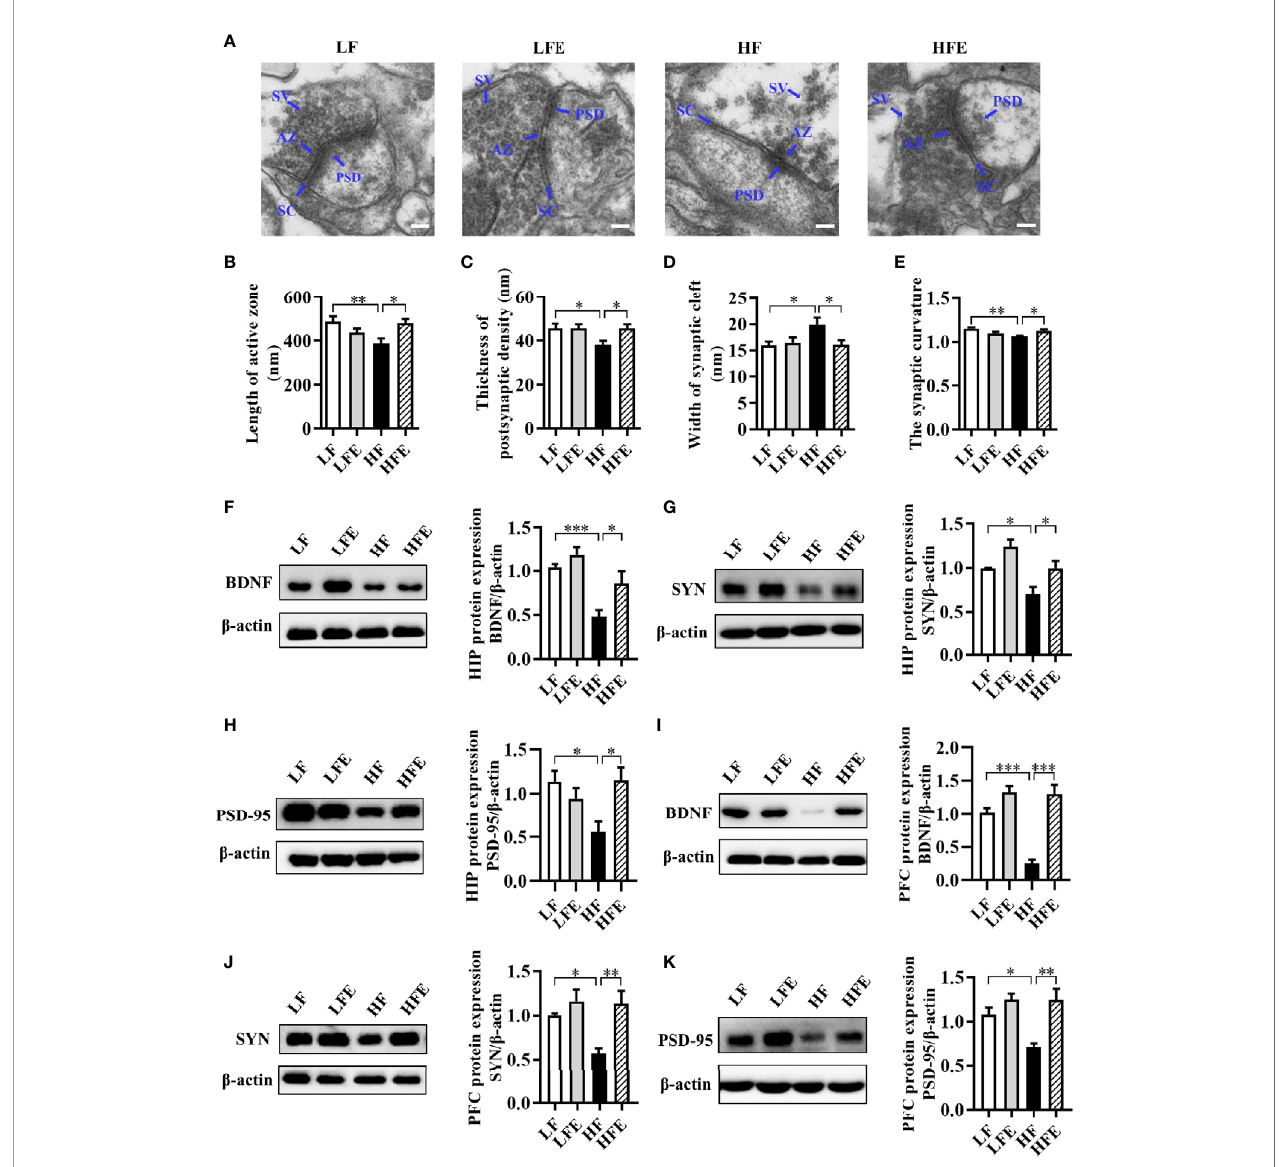
FIGURE 3 | ESPs supplementation ameliorated synaptic impairment in the HIP and PFC of HF diet-induced obese mice. (A) Representative ultrastructure of synapses in the CA1 region of mice on the electron micrograph (scale bar 100 nm). (B – E) Image analysis of the length of active zone, thickness of postsynaptic density, width of the synaptic cleft, and the synaptic curvature (n = 3, 6 images per mouse). AZ, active zone; PSD, postsynaptic density; SC, synaptic cleft; SV, synaptic vesicle. (F – H) The protein expression levels of BDNF, SYN and PSD-95 in the HIP (n = 8). (I – K) The protein expression levels of BDNF, SYN and PSD-95 in the PFC (n = 8). Values are represented as mean ± SEM. * P < 0.05, ** P < 0.01, *** P < 0.001. Tukey-Kramer